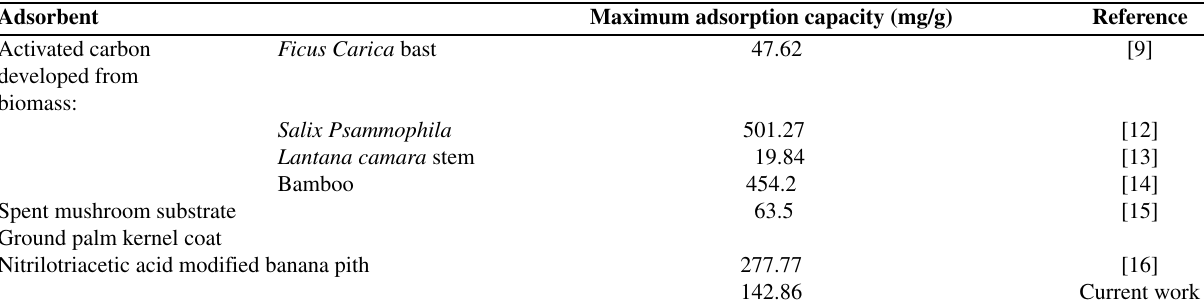
Table 1. Comparison of maximum adsorption capacity for Methylene Blue by various low cost adsorbents